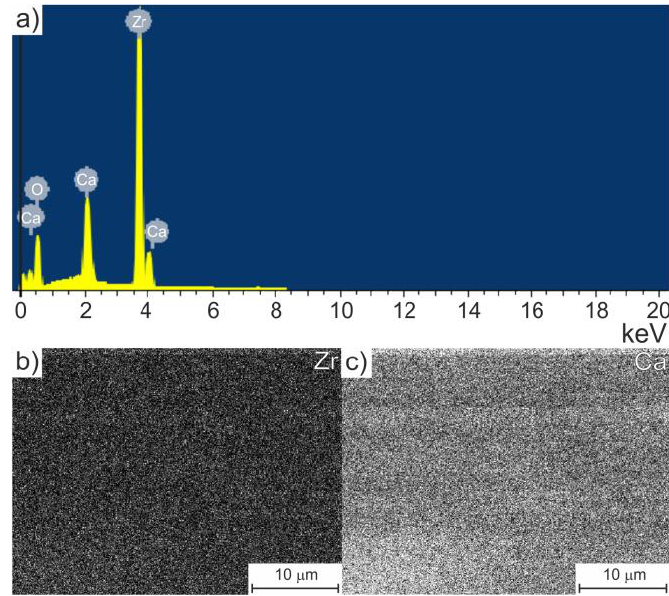
Figure 3. The results of ( a ) energy-dispersive X-ray spectrometer (EDS) analysis of the virgin Zr-doped CaO sorbent; ( b , c ) EDS mapping of Zr and Ca in the virgin Zr-doped CaO sorbent .